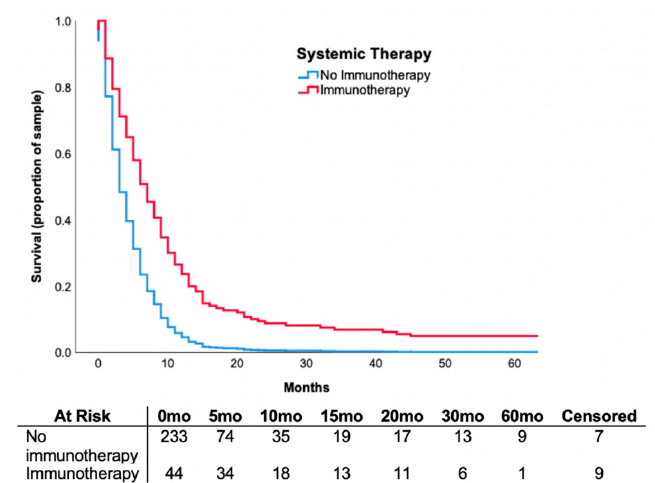
Figure 2. Proportional Cox regression survival curve demonstrating survival over months in patients receiving immunotherapy versus no immunotherapy. Hazard ratio (HR) = 0.375, 95% confidence interval (CI) = 0.246–0.574, p < 0.001 were associated with immunotherapy compared to no immunotherapy. Analysis controlled for age, LDH value, number of intracranial lesions, extent of extracranial disease, the presence of neurological symptoms, infratentorial lesions, surgery, radiation therapy type and